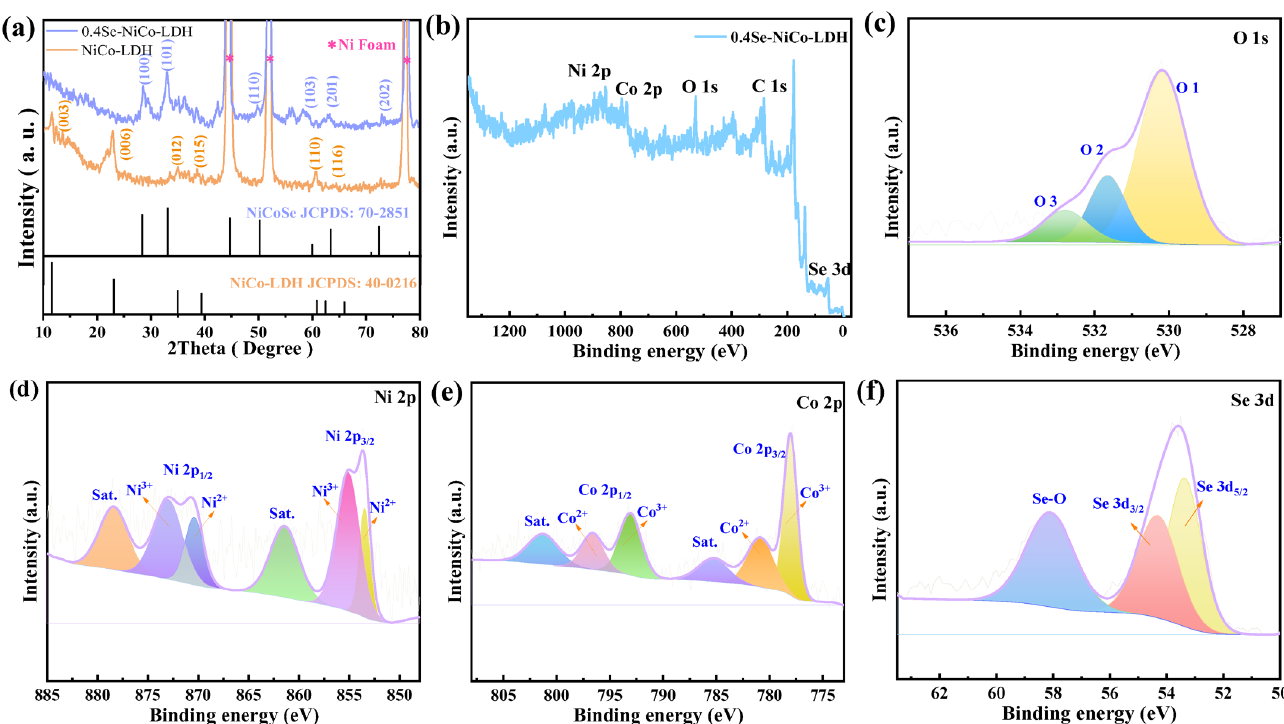
Batteries 2023 , 9 , x FOR PEER REVIEW Figure 1. Structural characterization ( a ) XRD patterns of the as-prepared samples, ( b ) the XPS full spectra of 0.4Se-NiCo-LDH sample, ( c ) O1s, ( d ) Ni 2p, ( e ) Co 2p, ( f ) Se 3d.